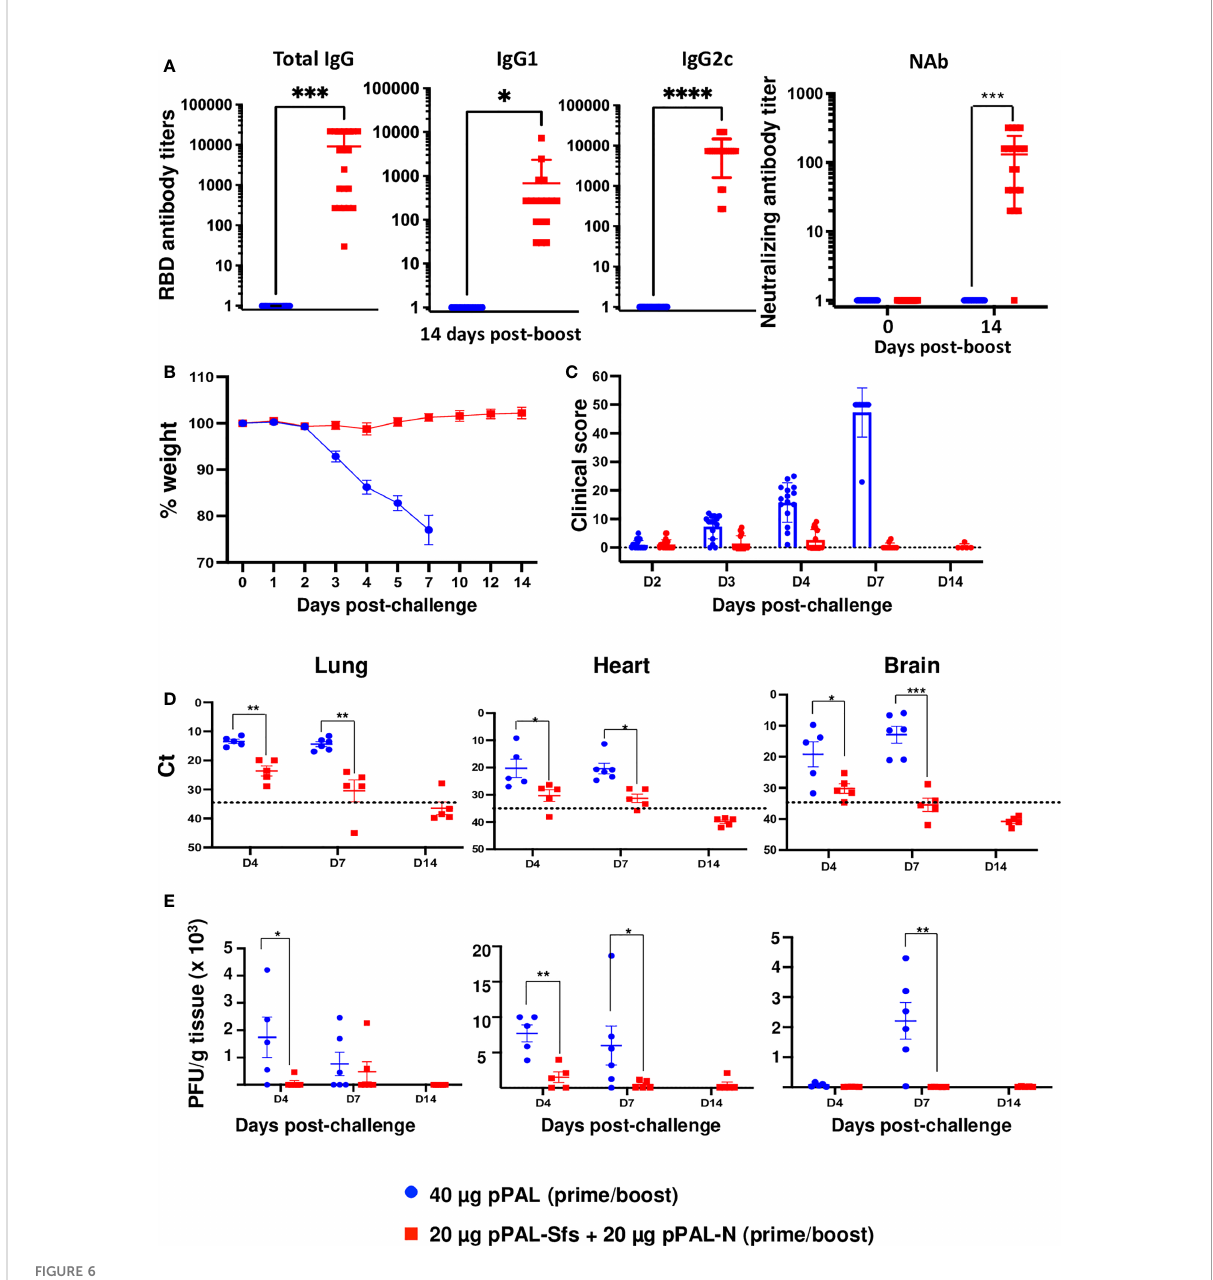
FIGURE 6 The pPAL-Sfs + pPAL-N vaccine confers full protection against challenge with 10 5 PFU of the MAD6 SARS-CoV-2 isolate in the K18-hACE2 murine model. (A) Titration of circulating anti-RBD IgG, IgG1, IgG2c, and neutralizing antibodies 15 days after prime/boost immunization with pPAL-Sfs + pPAL-N. (B) Body weight evolution after 10 5 PFU SARS-CoV-2 challenge. Vaccinated animals maintained their weight throughout the experiment. Weight decreased in the control group until the endpoint criteria had to be applied (20% of weight loss). (C) Clinical sign follow-up after challenge. (D) Reduction of the viral load in target organs. D Ct accounting for SARS-CoV-2 mRNA levels. b -actin was the reference gene. (E) Reduction of viral replication (PFU/g tissue) in VERO cells. Statistical inference was performed using the Student ’ s t-test applying p-value adjustment by the Holm-Sidak method ( a = 0.05; *p<0.05; **p<0.01; ***p<0.001;